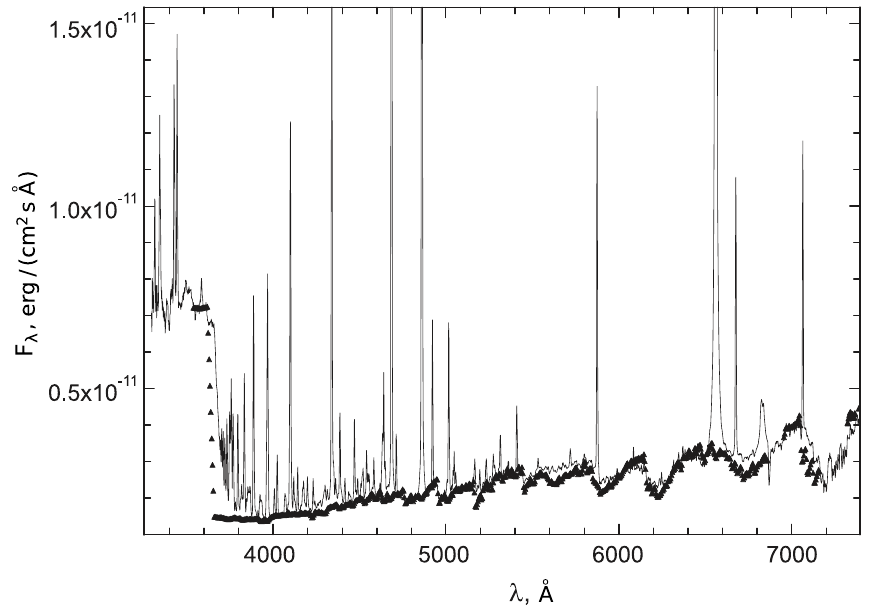
Fig. 5. Spectrum of AG Peg taken on 2015 August 18 and the model curve